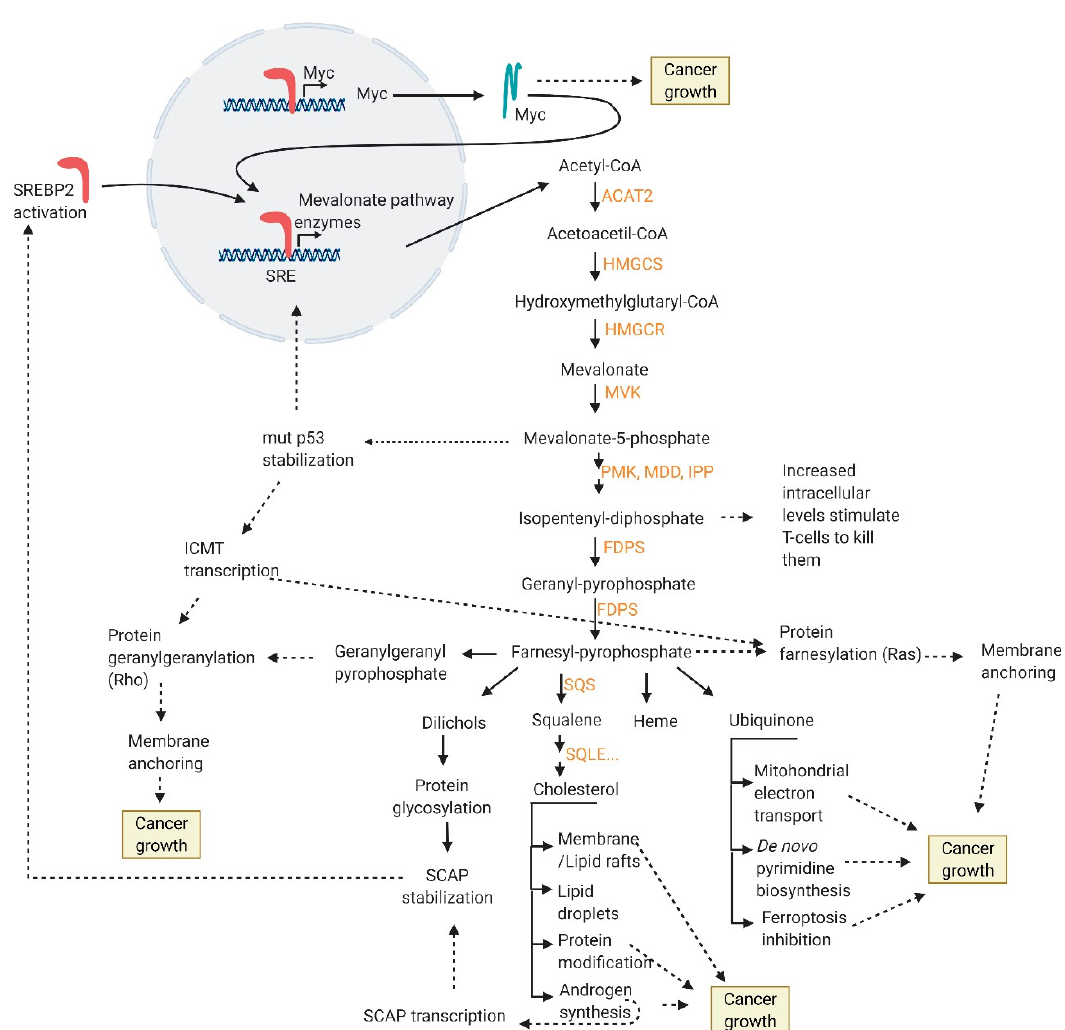
Figure 2. Cholesterol biosynthesis intermediates and products support prostate cancer growth. Enzymes involved in de novo cholesterol synthesis are indicated in orange. Acetyl-CoA acetyltransferase 2 (ACAT2), 3-hydroxy-3-methylglutaryl-CoA synthase (HMGCS), 3-hydroxy-3-methylglutaryl-CoA reductase (HMGCR), mevalonate kinase (MVK), phosphomevalonate kinase (PMK), diphospho-mevalonate decarboxylase(MDD), Isopentenyl-pyrophosphate isomerase (IPP), farnesyl-diphosphate synthase (FDPS), squalene synthase (SQS), squalene monooxygenase(SQLE), sterol regulatory element–binding protein-2 (SREBP2), sterol response element (SRE), isoprenyl-cysteine carboxyl methyltransferase (ICMT). Created with BioRender.com (accessed on September 5th, 2021).